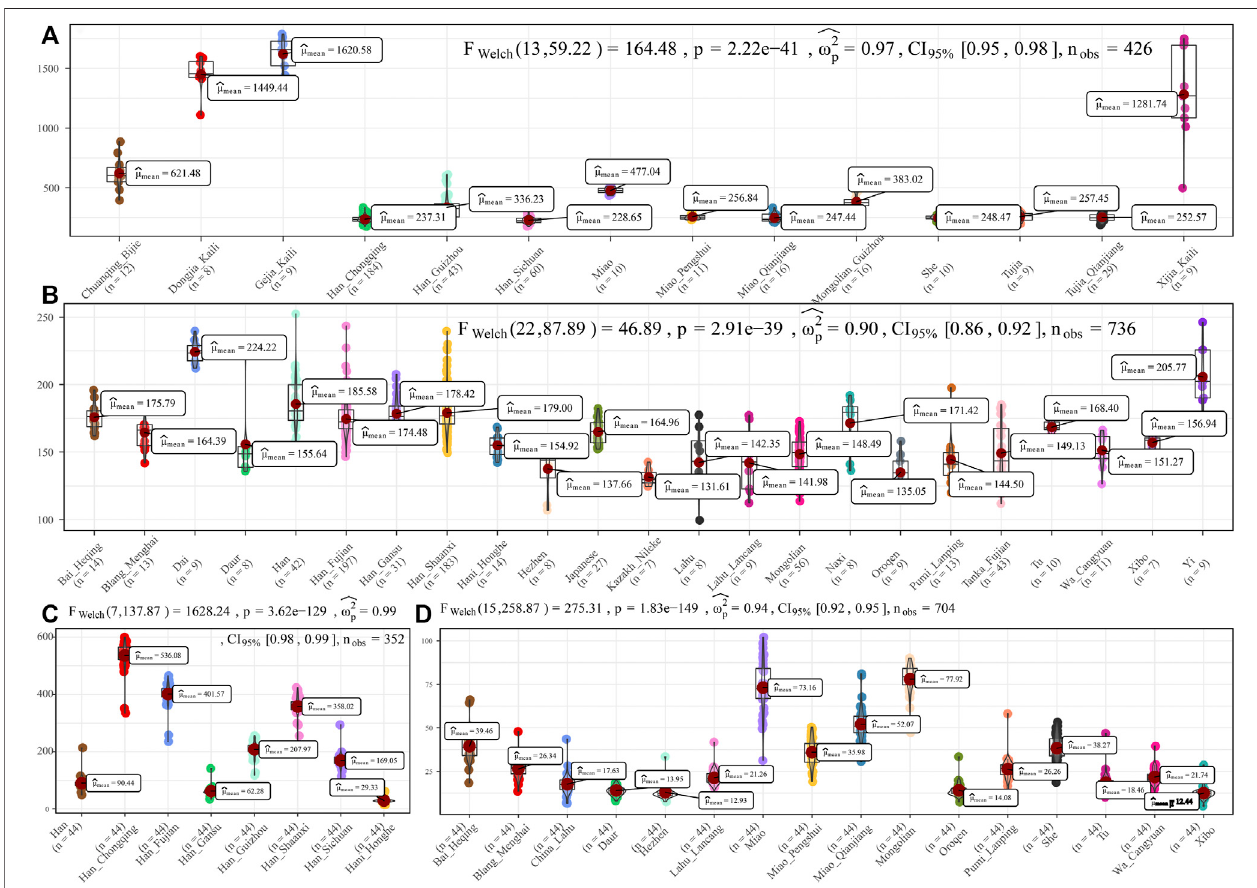
FIGURE 2 | Chromosome painting between Hmong – Mien people and other East Asian reference populations. (A,B) Amount of total length of DNA fragments of modern East Asians copied from donor chromosomes related to Sichuan Miao. (C,D) Average DNA chunk of Sichuan Miao copied from other East Asians. Statistical indexes showed the results of inter-population comparisons. Only unrelated individuals are used